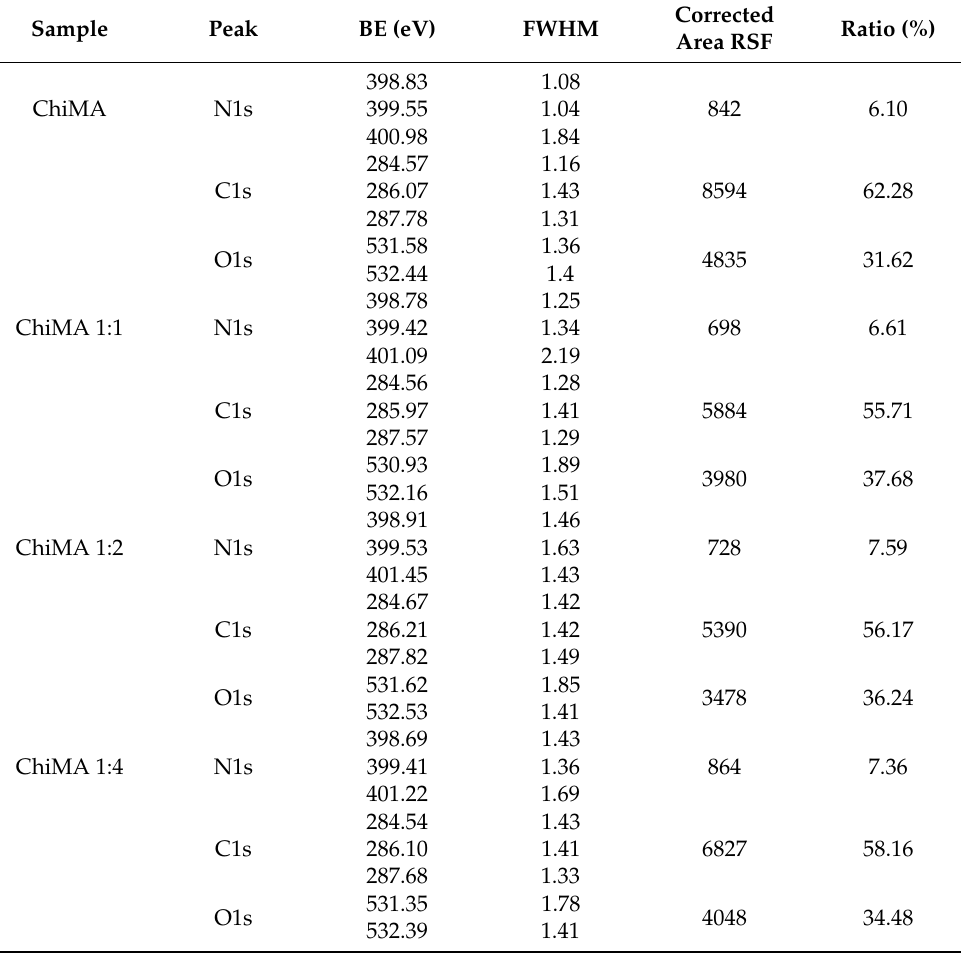
Table 1. Surface chemical analysis and elemental composition (%) of the chitosan and ChiMA 1:1, 1:2, and 1:4 samples. Details of C1s, N1s, and O1s decomposed peaks and related binding energies (BE) and FWHM values.